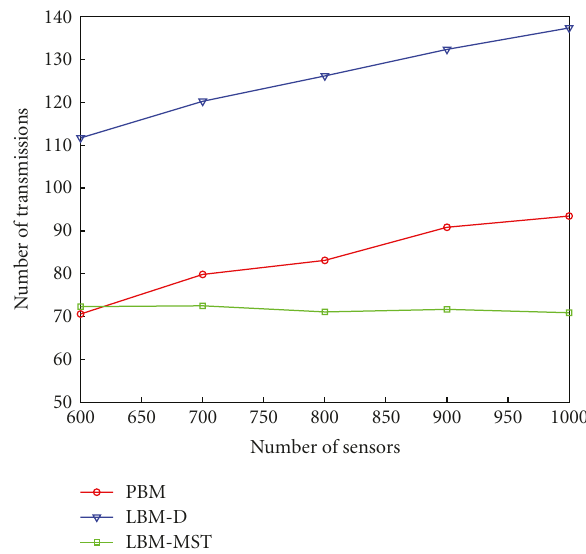
Figure 12: Number of transmissions for randomly located destina- tions.